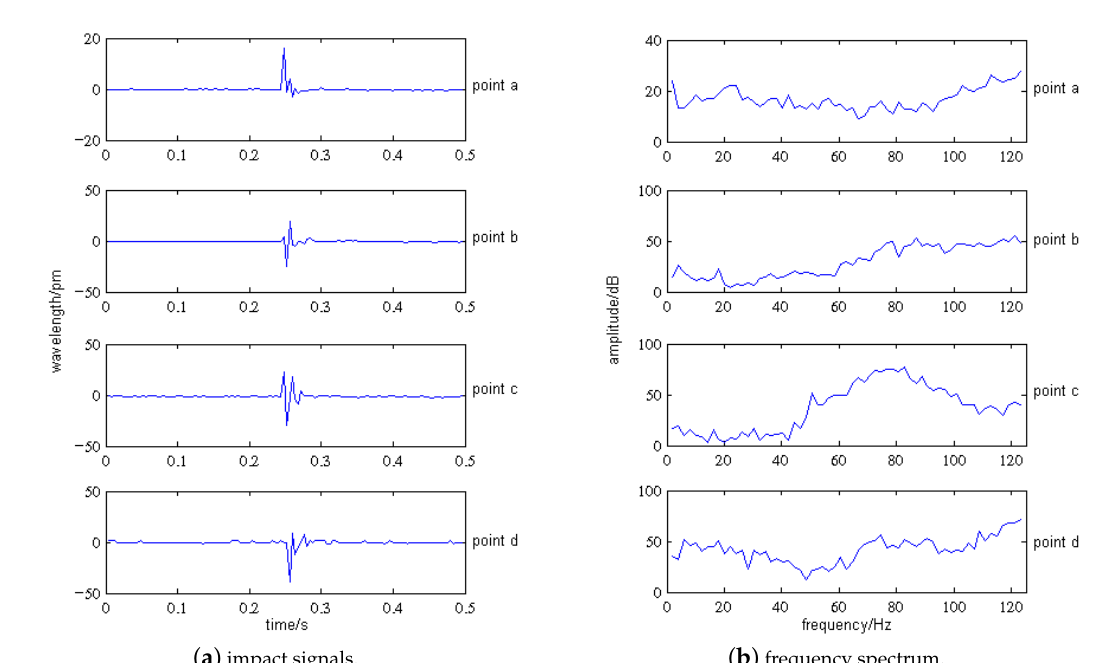
Figure 10. Signals and spectrogram of sensor No. 2 under 1